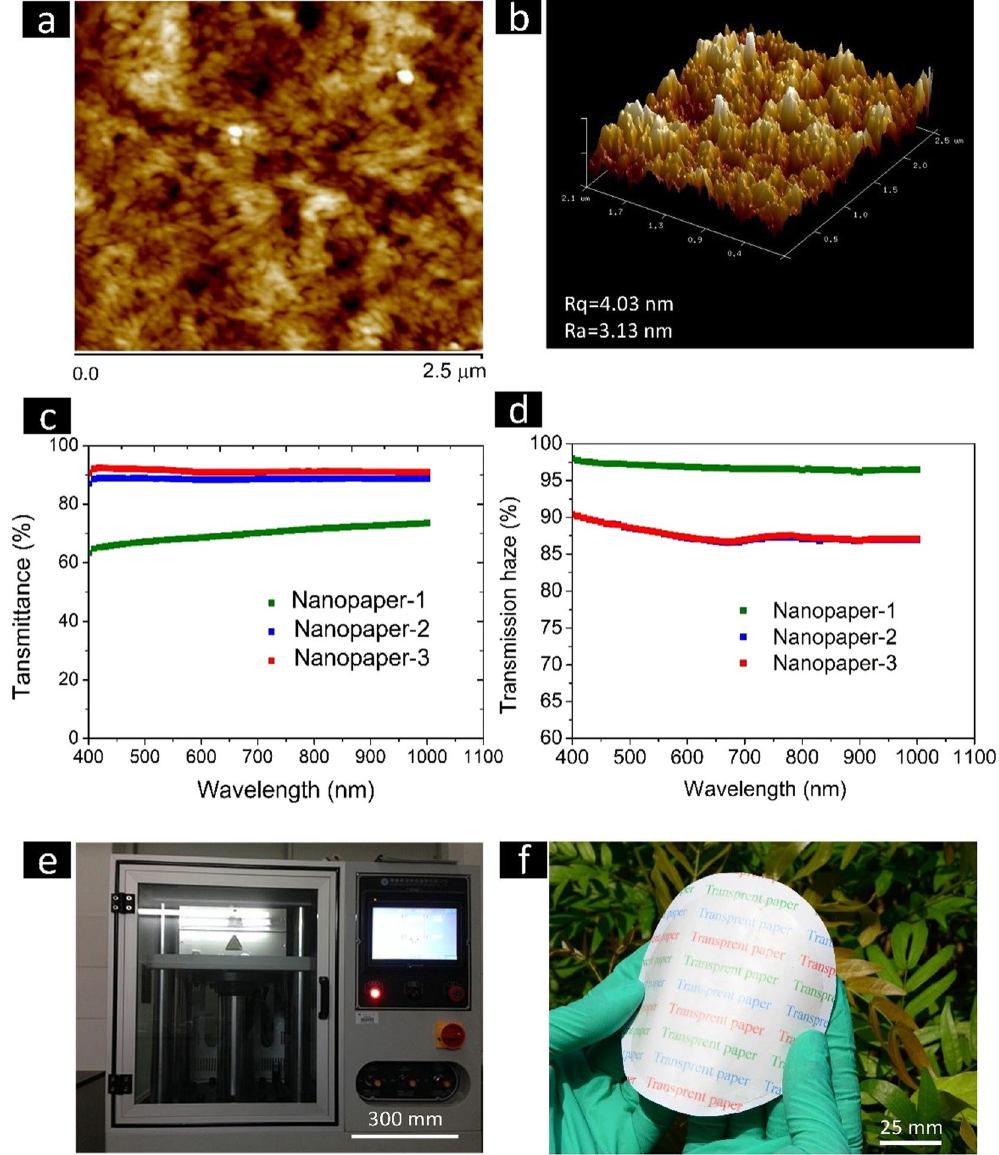
Figure 4. Surface morphology of the nanostructured paper is studied by AFM for 2-D height image ( a ) and 3-D height image ( b ) at the scan size of 2.5 μ m × 2.5 μ m. Optical transmittance curve ( c ) and optical haze ( d , 550 nm) of the different nanostructured paper samples ranging from 400 nm to 1100 nm were compared. Digital images of the experimental equipment ( e ) and the fabricated nanostructured paper with dually high tranparency and haze ( f